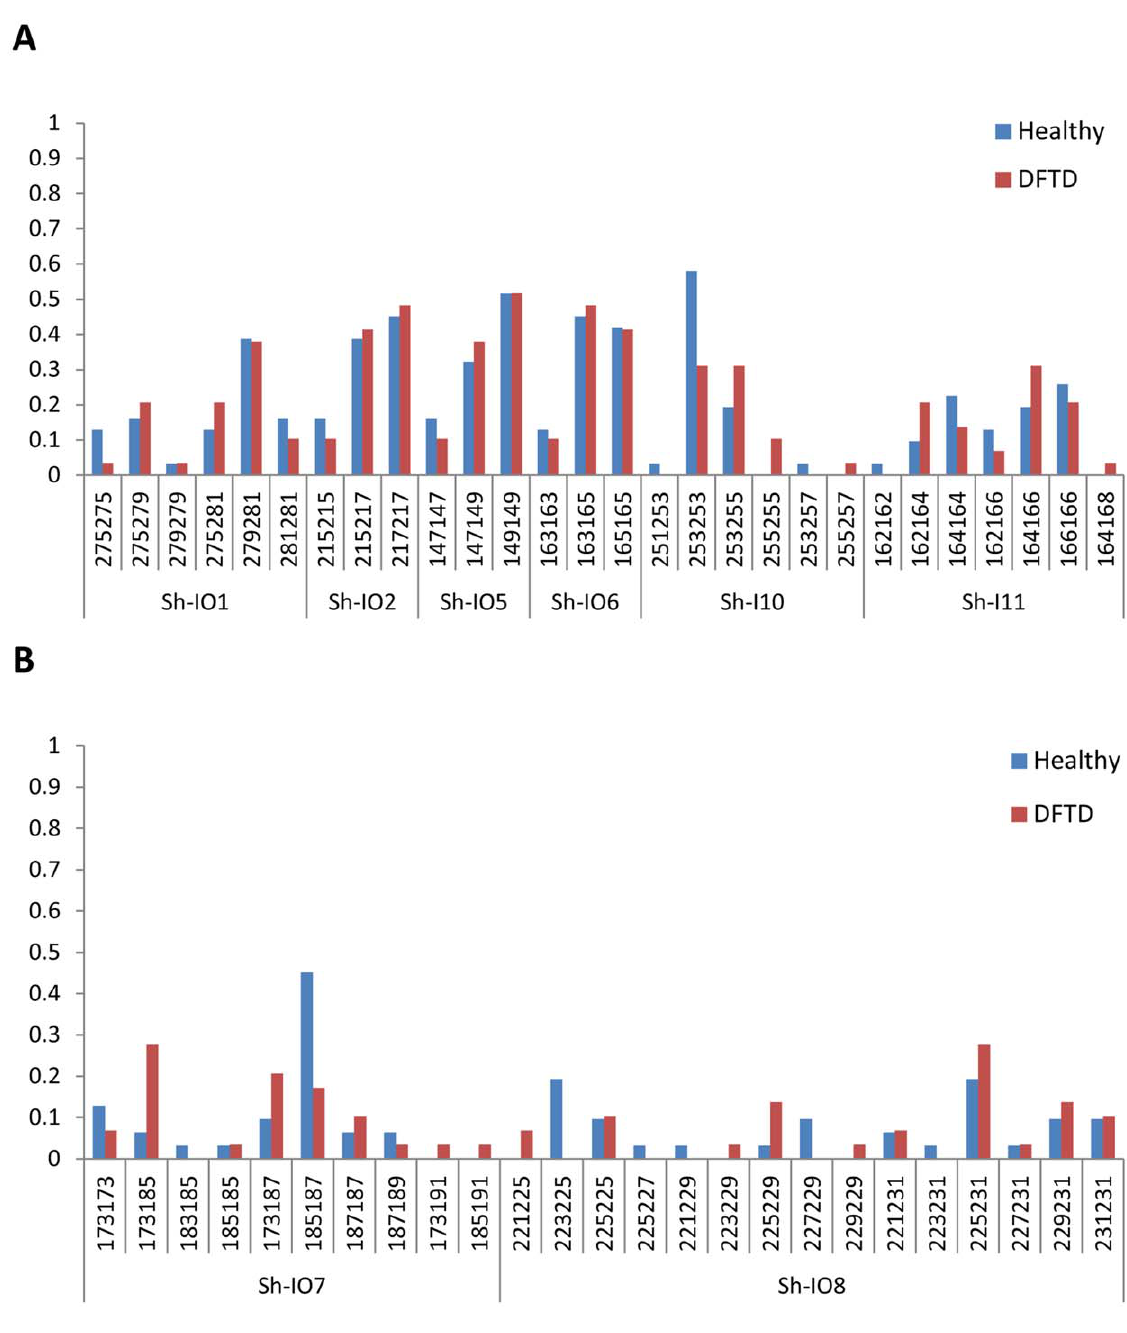
Figure 3. Genotype frequencies for healthy and DFTD infected devils. ( A ) At the six microsatellite loci associated with antigen-presenting genes within the MHC (Sh-I01, Sh-I02, Sh-I05, Sh-I06, Sh-I10 and Sh-I11). No deviations from Hardy-Weinberg equilibrium are observed for either healthy or DFTD infected devils. ( B ) For two microsatellite markers more closely associated with non-antigen presenting genes within the MHC region (Sh-I07 and Sh-I08). The Sh-I07 locus is out of Hardy-Weinberg equilibrium for healthy devils only (p=0.029) and the Sh-I08 locus does not conform to Hardy-Weinberg equilibrium at the 0.1 significance level (p=0.076). Three differences in genotype frequencies were significant before Bonferroni correction (Sh-I07:173/185, p=0.041 and 185/187, p=0.024; Sh-I08:223/225,